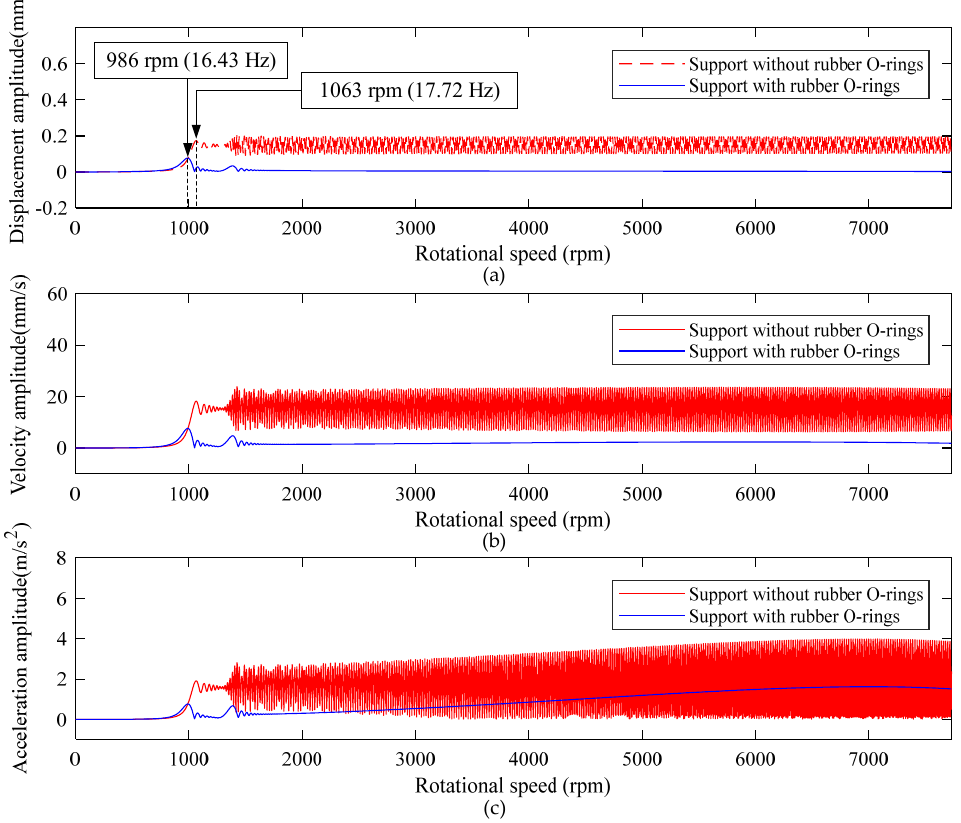
Figure 14. Dynamic response of point A (node 51) of support without rubber O-rings and support with rubber O-rings under the speed-up time of 60 s. ( a ) Displacement amplitude curve; ( b ) velocity amplitude curve; ( c ) acceleration amplitude curve.